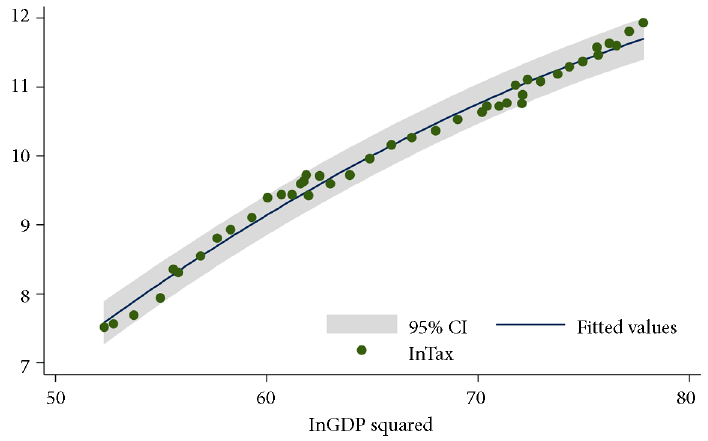
Figure 4. U-shaped relations between Tax and GDP